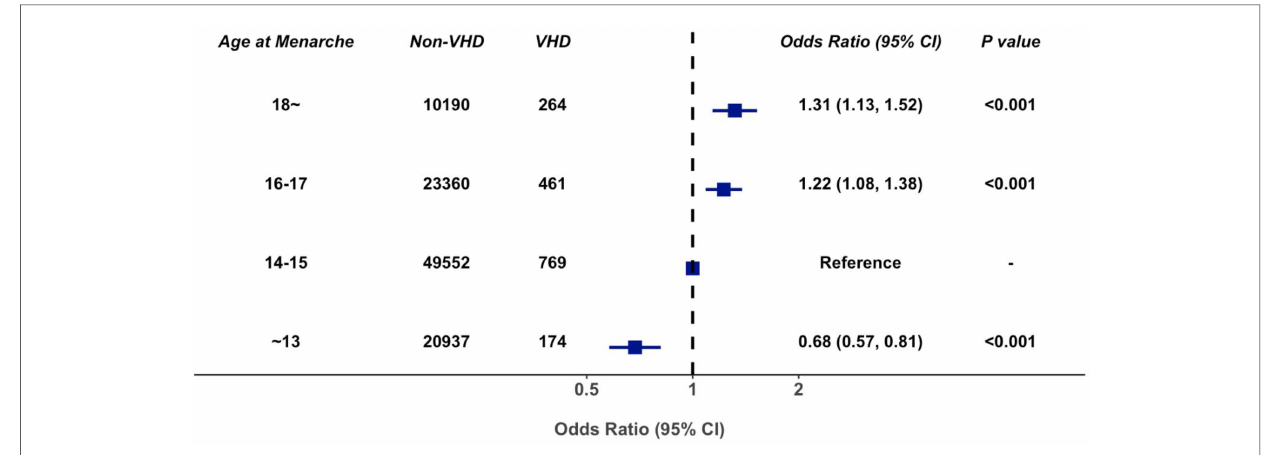
FIGURE 3 Association of age at menarche with valvular heart disease, adjusted for age, smoking status, systolic blood pressure, antihypertensive agents, diabetes mellitus, body mass index, high density lipoprotein cholesterol, and total cholesterol. 95% CI, 95% con fi dence interval; VHD, valvular heart disease.